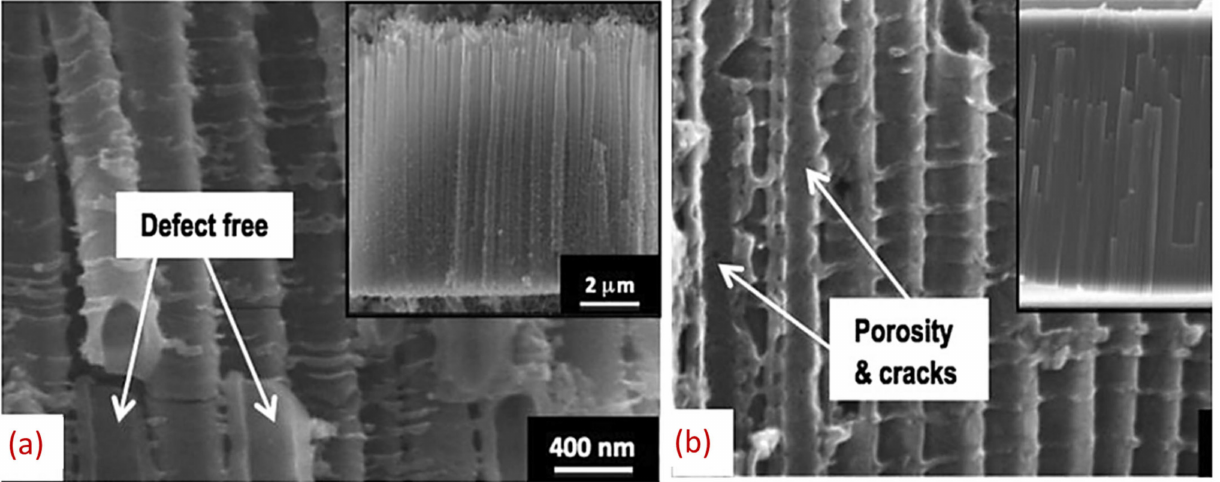
Figure 19. Cross-sections of ( a ) ILNTs and ( b ) AFNTs. Insets in ( a , b ): low-magnification side views showing tube lengths. Reprinted with permission from Ref. [234]. Copyright 2014